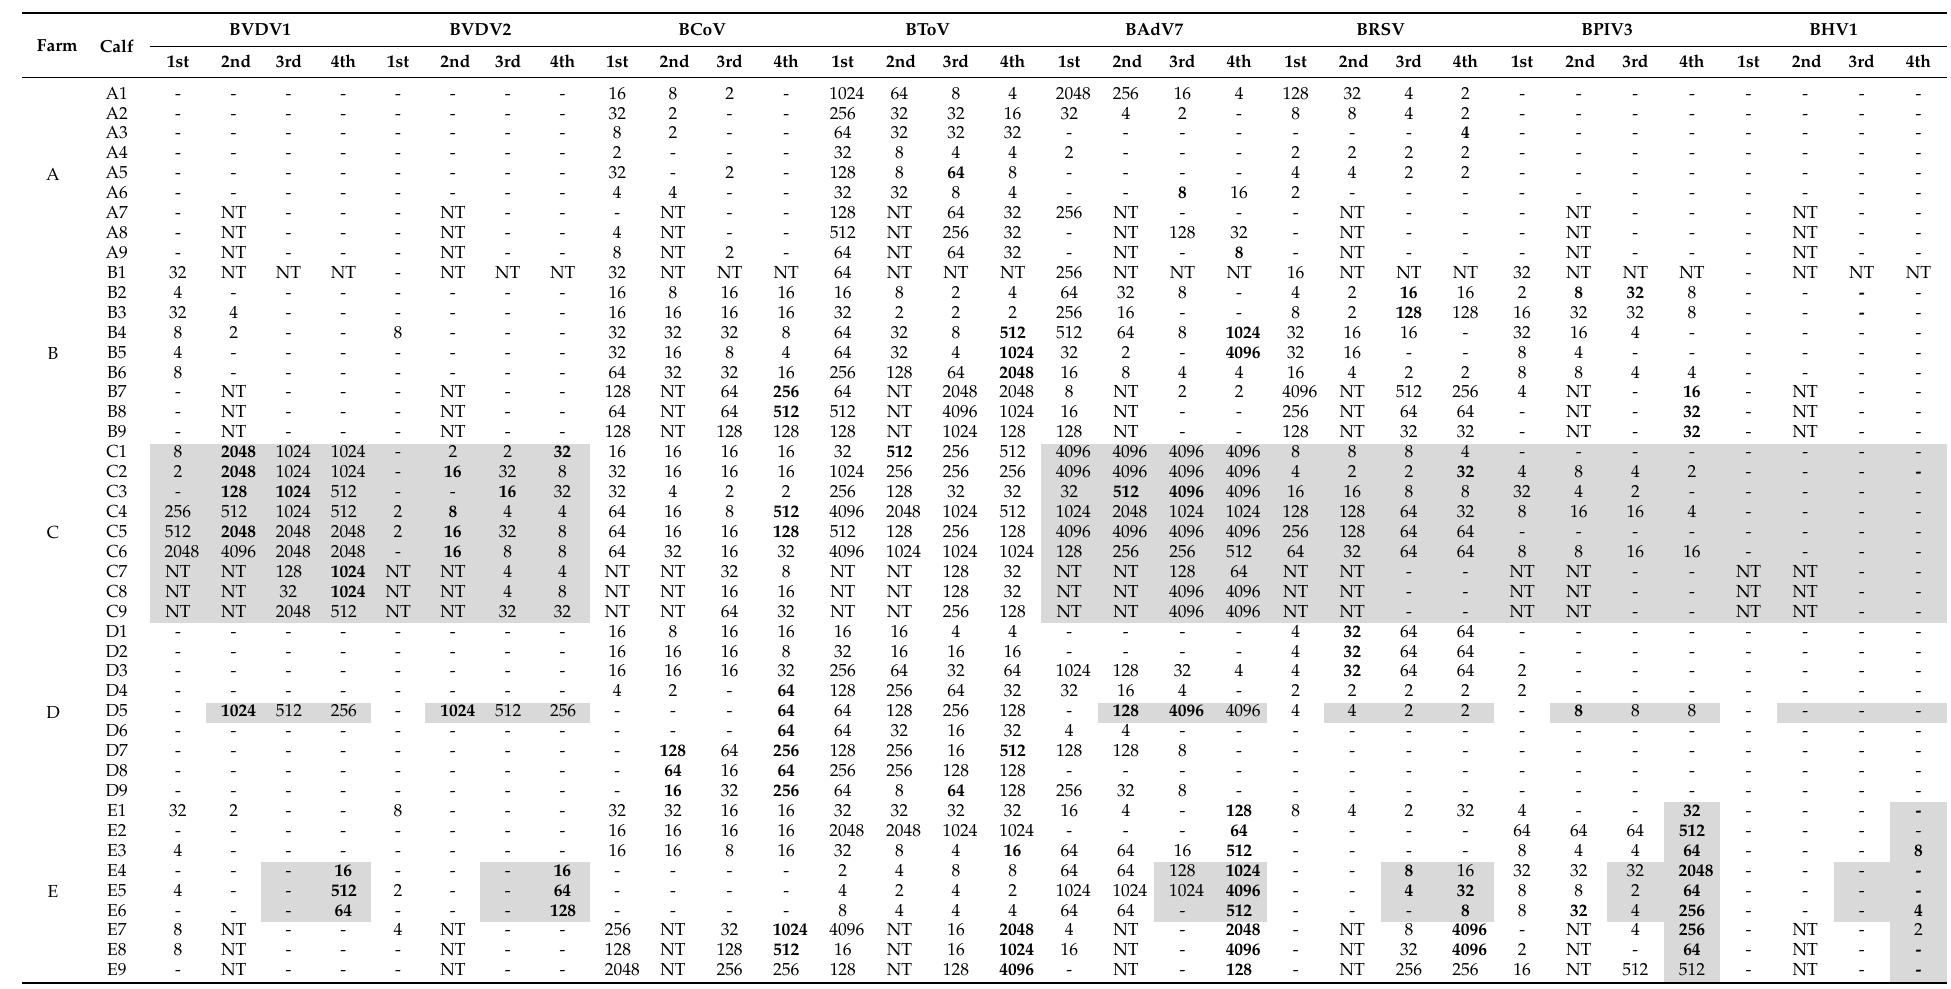
Table 2. Summary of antibody titers by virus neutralization tests against bovine viral diarrhea viruses (BVDV1 and BVDV2), bovine coronavirus (BCoV), bovine torovirus (BToV), bovine adenovirus serotype 7 (BAdV7), bovine respiratory syncytial virus (BRSV), bovine parainfluenza virus 3 (BPIV3), and bovine herpes virus 1 (BHV1) using 232 sera from 63 clinically healthy